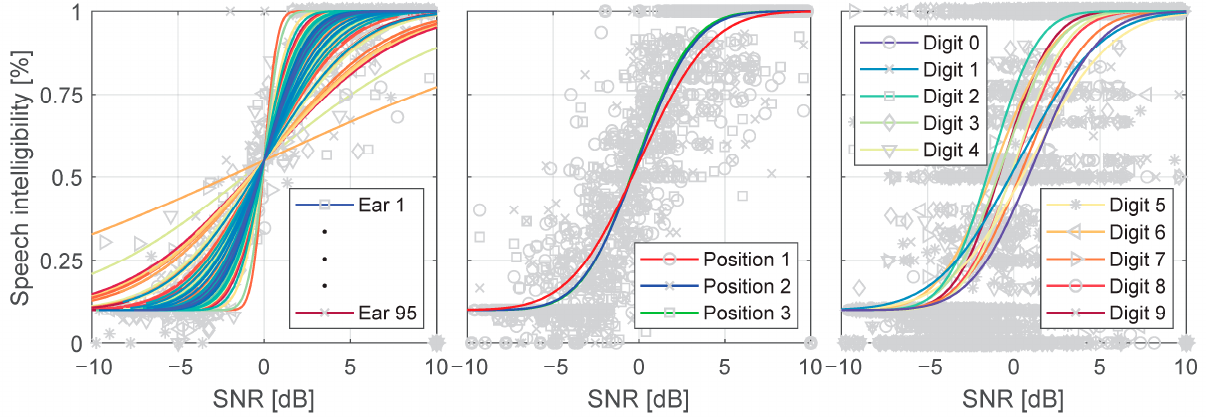
Figure 4. Example of psychometric functions for modulated noise in the investigated group: psychometric functions adjusted for ear SRT (left panel), position-specific (middle panel) and digit-specific (right panel) psychometric functions.